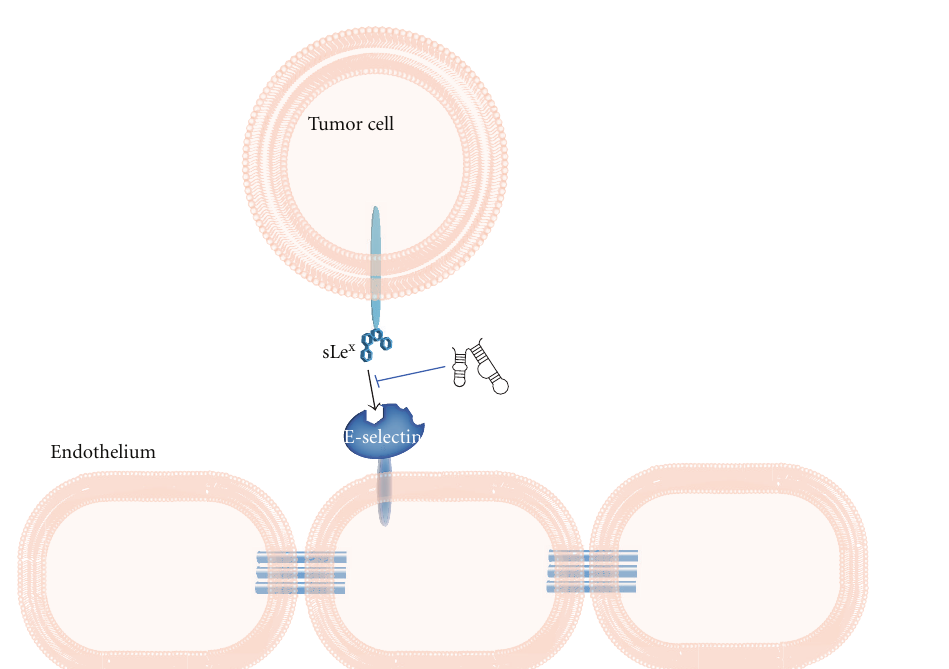
Figure 2: Aptamers as blocking agents. Aptamers, in this case composed of phosphorothioates, selectively bind to E-selectin that is presented on the surface of human endothelial cells. The aptamers serve as antagonist for the interaction to sialyl Lewis X on HL-60 cells, a human promyelocytic leukemia cell line, thereby inhibiting the adhesion of tumor cells by more than 75%.